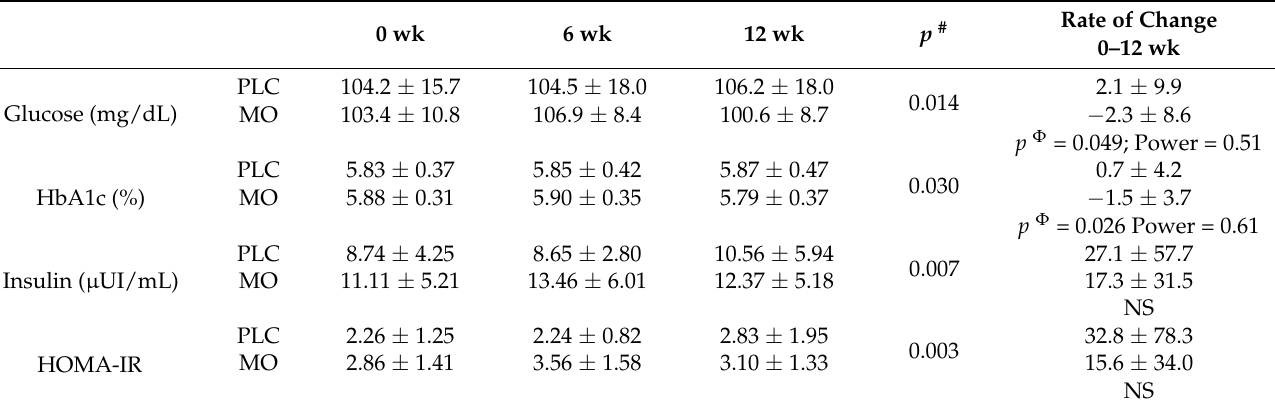
Table 2. Glycemic control biomarkers in patients with prediabetes of the PLC and MO groups during the